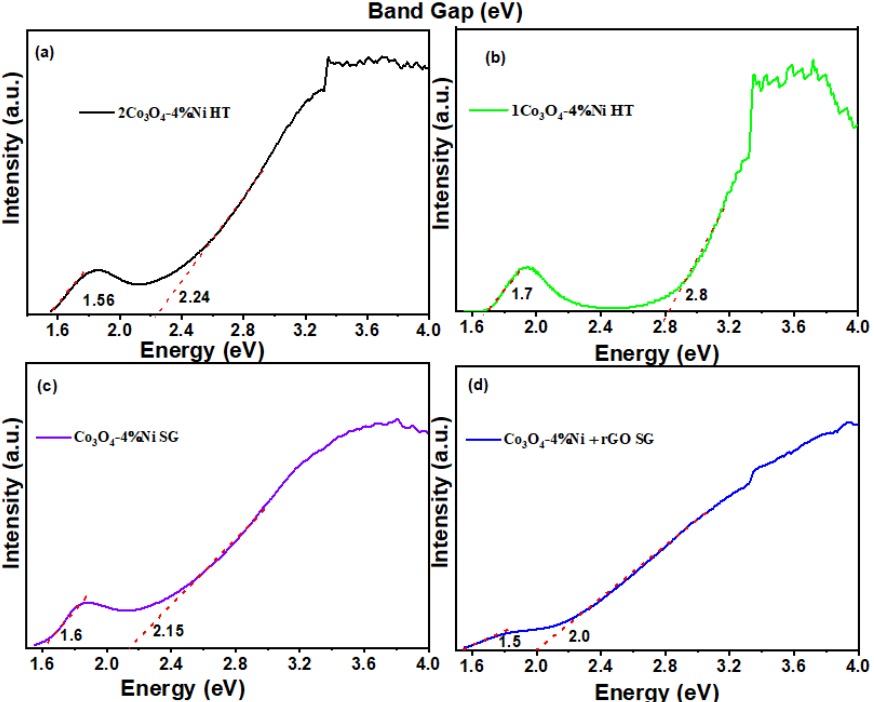
Figure 6. UV–Vis of Co 3 O 4 samples with 4% Ni at 400 ◦ C: ( a ) 2Co 3 O 4 -4%Ni HT, ( b ) 1Co 3 O 4 -4%Ni HT, ( c ) Co 3 O 4 -4%Ni SG, ( d ) Co 3 O 4 -4%Ni+rGO SG. Table 1. The conduction band (CB) and valence band (VB) calculated according to the Mulliken electronegativity.